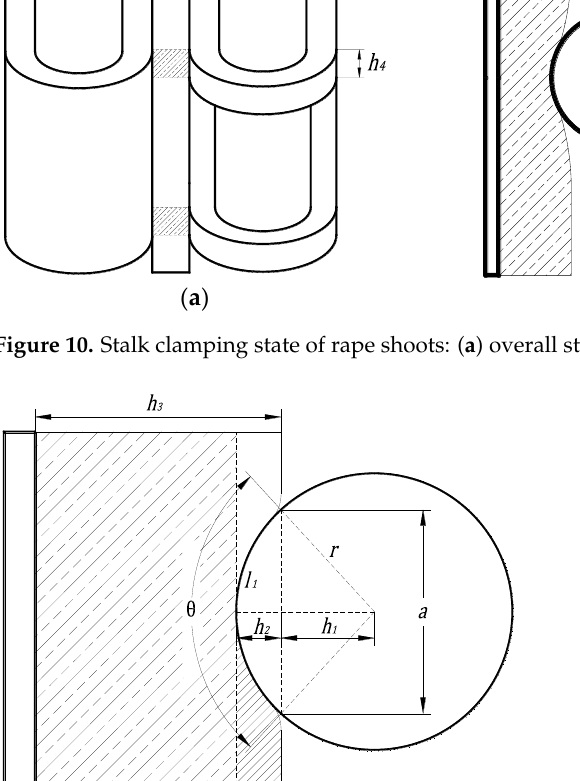
Figure 10. Stalk clamping state of rape shoots: ( a ) overall status; ( b ) local status.